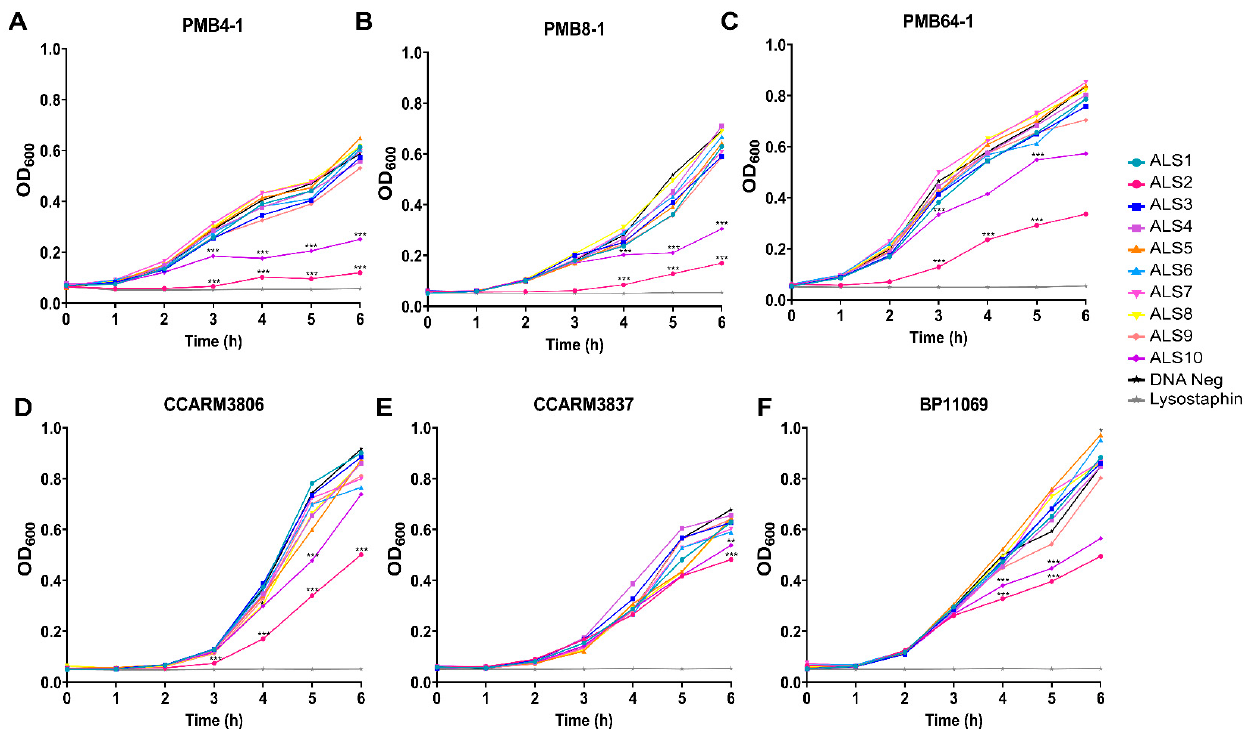
Figure 2. Screening of antibacterial activity of chimeric lysin candidates. Chimeric lysin candidates